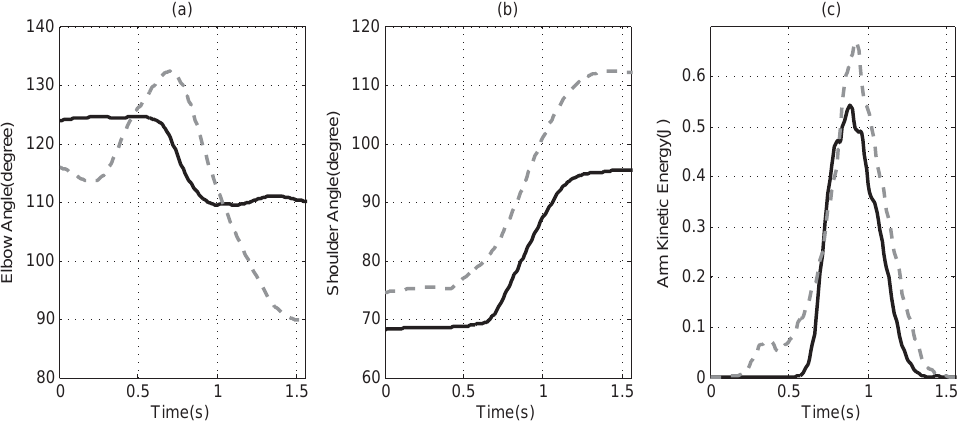
Figure 9: Measured elbow, shoulder joint angles and energy property profiles of two trajectories in Case D : (a) elbow joint angle plots, (b) shoulder joint angle plots, (b) arm kinetic energy